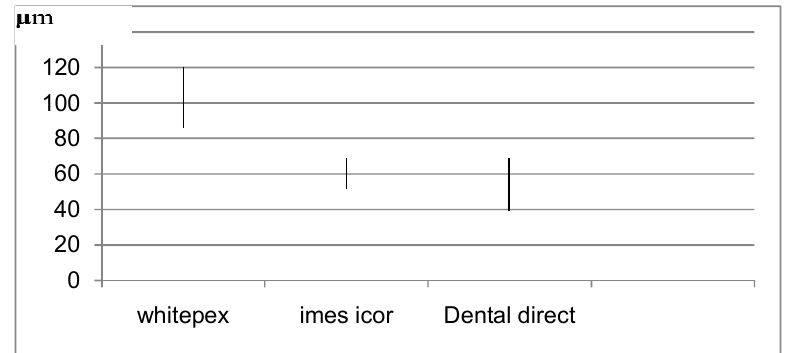
Figure 10: Charts of the results of marginal gap measurements Table 1: Descriptive statistics of vertical marginal gap measurements (μm) Groups